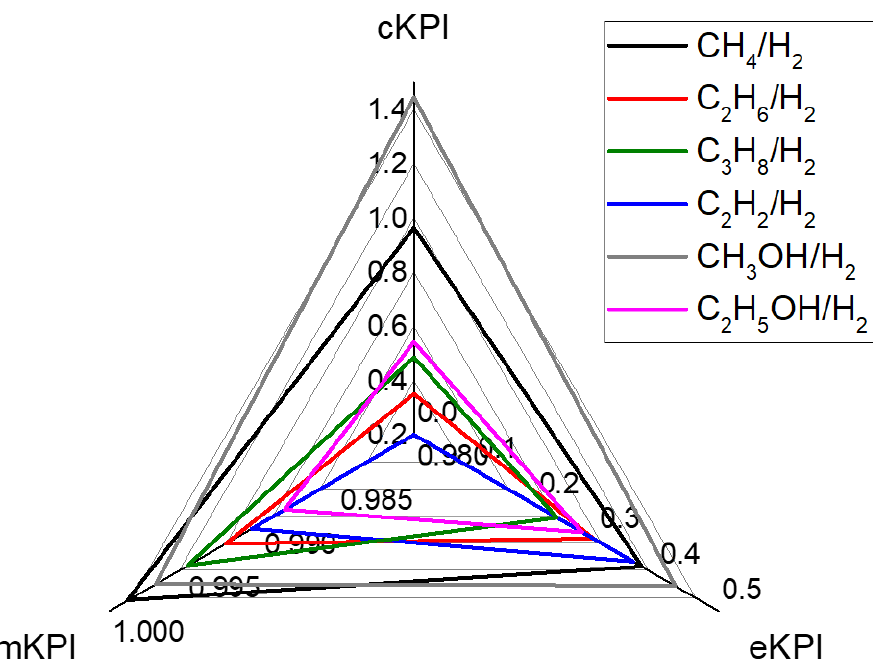
Figure 8. A comparison of energy, environmental, and maturity key performance indicators for hydrogen-containing mixtures. hydrogen-containing